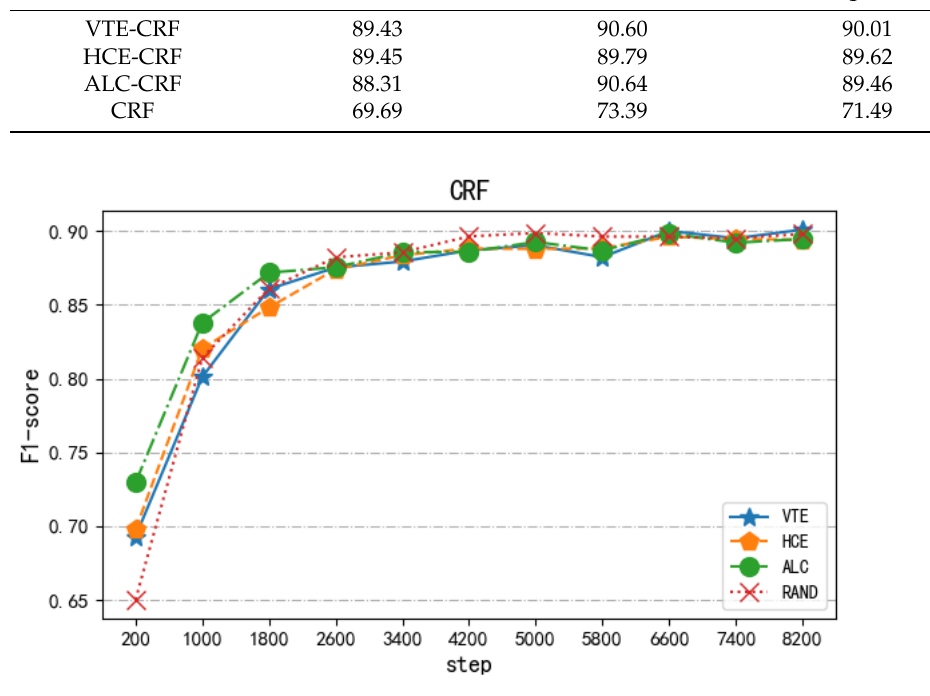
Figure 8. The performance of these algorithms based on the CRF model.